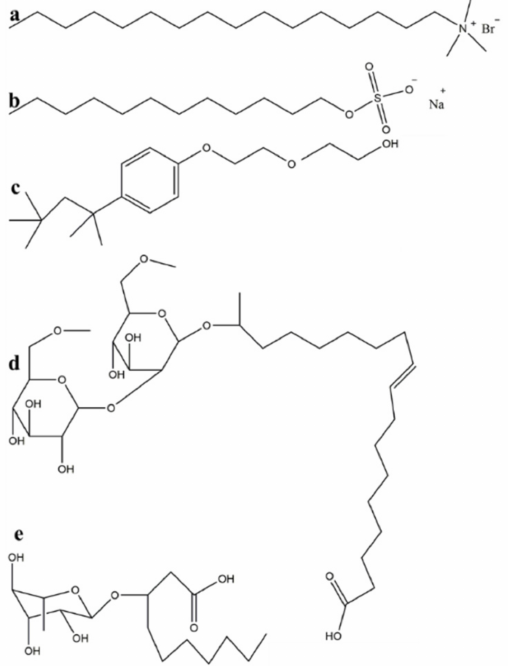
Figure 1. Structure of five surfactants ( a ) CTAB; ( b ) SDS; ( c ) TX-100; ( d ) sophorolipid; ( e )